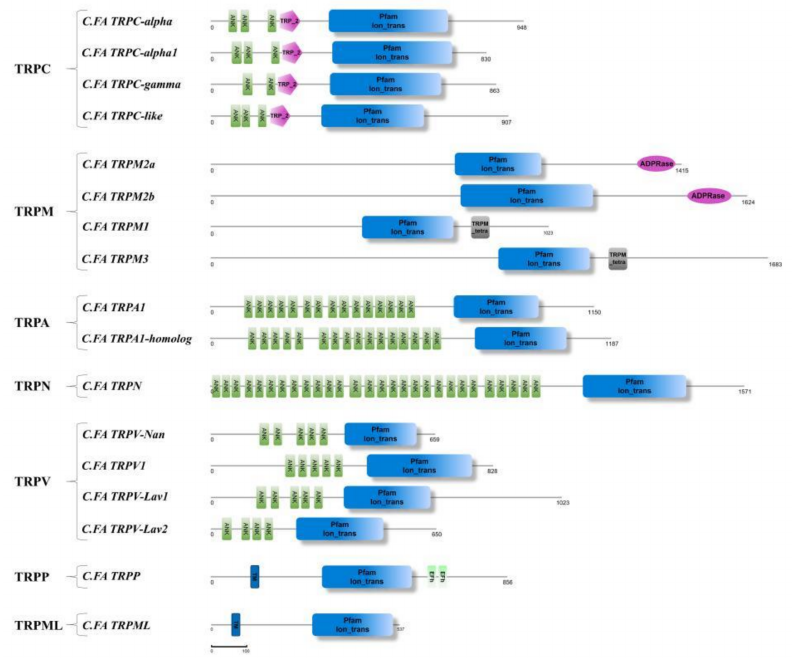
Figure 1. Protein structure of TRP family genes in C. farreri . The blue boxes are Pfam Ion trans domain which contains six transmembrane regions. The green boxes are Ankyrin repeat domain. The pink pentagons are the TRP 2 domain. The gray boxes are the TRPM tetra domain. The pink ovals are the ADPRanse domain. The fluorescent green boxes are the EFh domain.